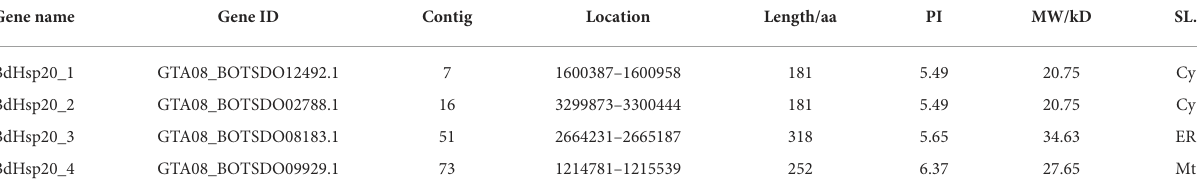
TABLE 1 Basic features of the BdHsp20 gene family.